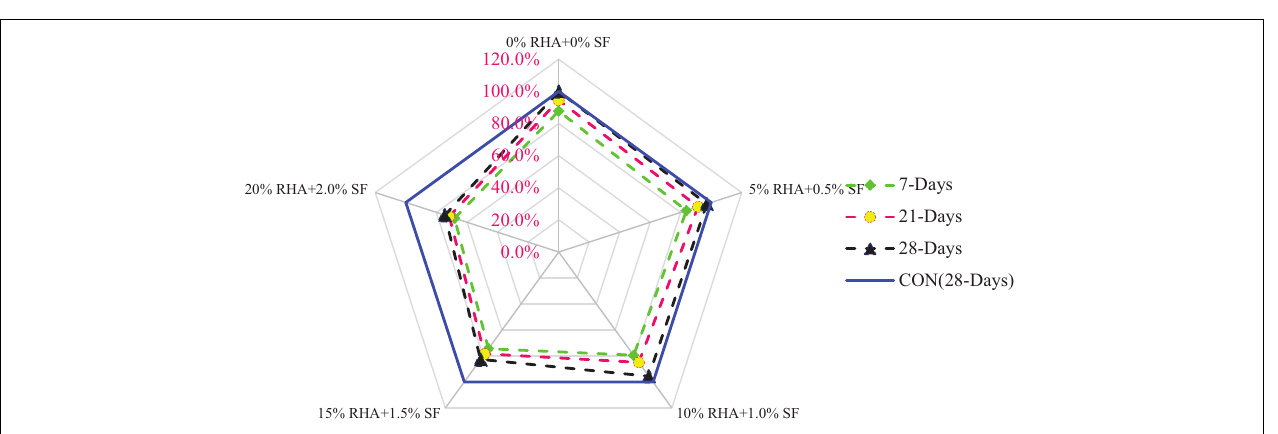
FIGURE 5 | Relative analysis of compressive strength (with steel fibers and